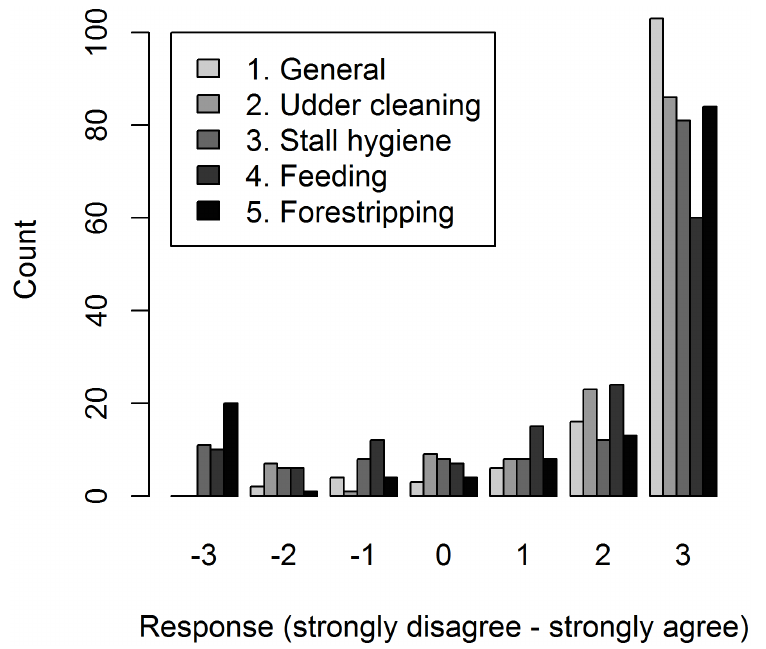
Fig 2. Dairy farmers’ intentions to implement mastitis control measuresbased on 134 farmersin North-Western Ethiopia.